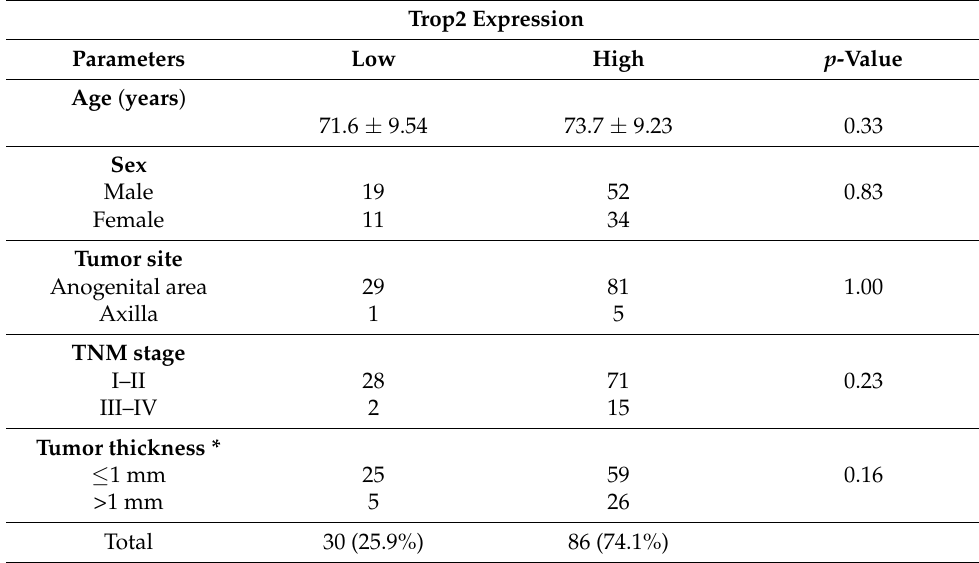
Table 3. Clinicopathological factors associated with Trop2